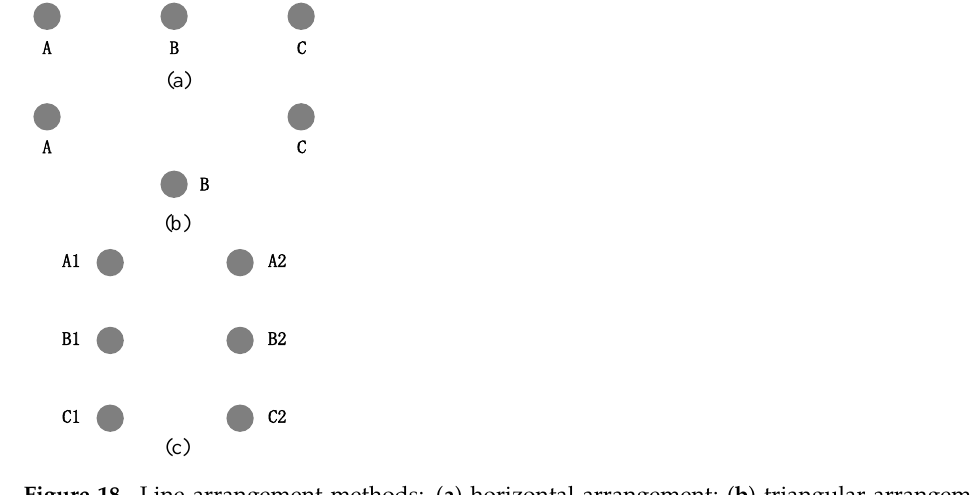
Figure 18. Line arrangement methods: ( a ) horizontal arrangement; ( b ) triangular arrangement; ( c ) double-back vertical arrangement.